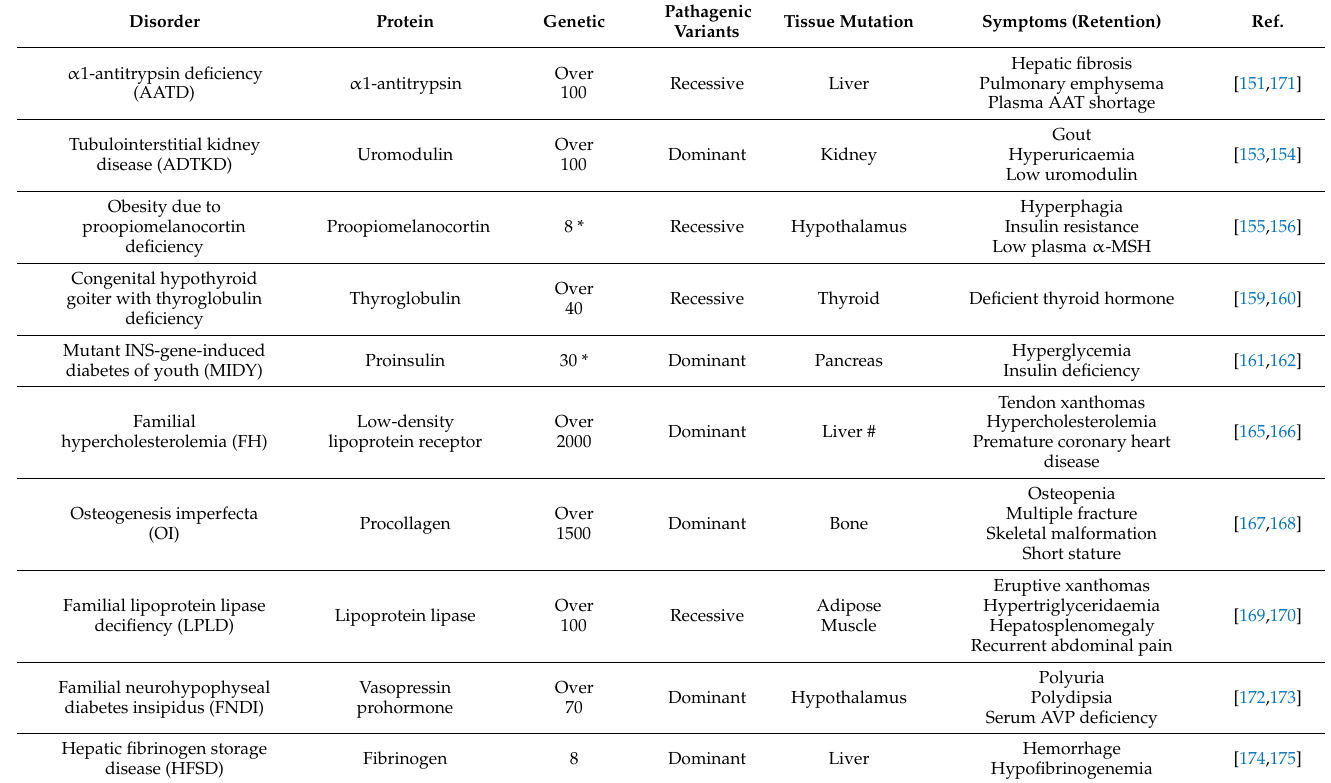
Table 1. ER storage